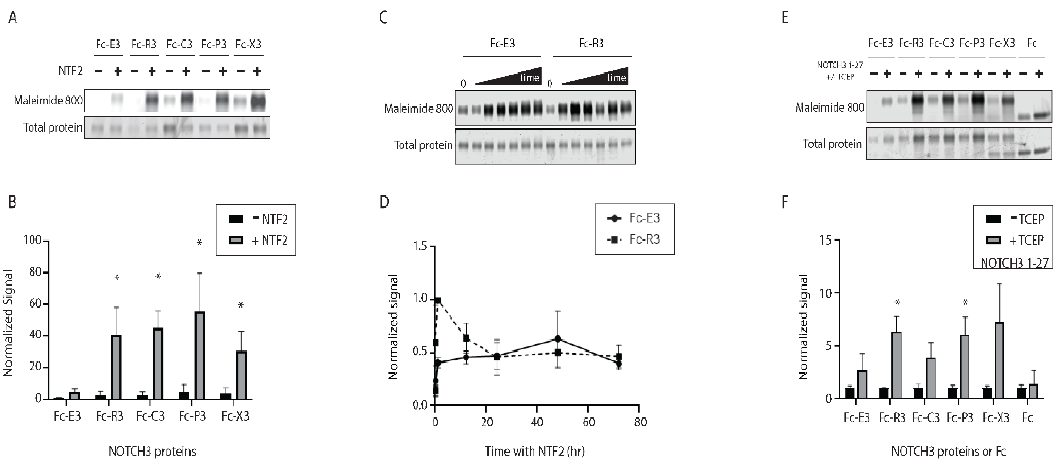
Figure 5. Relative trans-reduction of NOTCH3 wild type and mutant fragments. ( A ) Purified NOTCH3 wild type (Fc-E3) and mutants (Fc-R3, Fc-C3, Fc-P3, and Fc-X3 corresponding to mutations R90C, C49Y, R75P, and R141C) containing the first three EGF repeats were co-incubated with 2 µg NTF2 and then labeled with maleimide dye. Gel scanning to detect the reduced proteins is shown (upper panel). Simply Blue staining shows the total protein loaded for each group (lower panel). ( B ) Maleimide 800 signal was normalized by the total protein loaded and a comparison of the wild type and mutants is shown (significant difference were seen between Fc-R3, Fc-C3, Fc-P3, and Fc-X3 compared to control Fc-E3; * p < 0.05). ( C ) Fc-E3 (wild type) and Fc-R3 (R90C) were incu- bated with 2 µg NTF2 for 0, 1, 12, 24, 48, and 72 h (total volume loaded 5 µL). Maleimide dye labeling was performed at the end of each incubation period to assess NTF2 trans-reduction (upper panel). Simply Blue total protein stain shows the amount of Fc-E3 or Fc-R3 protein loaded (lower panel). ( D ) Quantification of the time course was performed, disclosing an increase in labeling at early time points for the mutant protein. ( E ) To test if large NOTCH3 fragments possess trans-reducing activ- ity, TCEP bead-reduced human NOTCH3 ectodomain that included EGF domains 1 – 27 was mixed with wild type and mutant NOTCH3 fragments followed by maleimide dye labeling and gel scan- ning (upper panel). TCEP was removed from NOTCH3 ectodomain by centrifugation. Simply Blue total protein stain shows the amount of protein loaded for each sample (lower panel). As a control, untreated NOTCH3 1 – 27 protein was also used to challenge wild type and mutant NOTCH3 frag- ments. ( F ) Gel quantification shows increased maleimide labeling after challenge with TCEP bead- reduced NOTCH3 1 – 27, relative to treatment with oxidized NOTCH3 1 – 27. TCEP bead-treated NOTCH3 1 – 27 trans-reduced two of four mutant target proteins with greater efficiency than wild type target protein (Fc-R3 and Fc-P3 vs. Fc-E3, * p < 0.05). All experiments were performed at least three times and included in the final quantified summary.